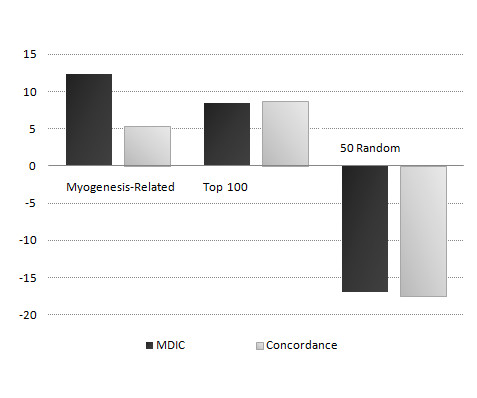
The improvement or deterioration of genes ranking in Sartorelli. Firstly, we selected 100 informative and 50 uninformative genes using Tomczak dataset and extracted their ranks in Sartorelli. Secondly, we trained 1PB classifier on Tomczak and tested on Sartorelli. Finally, we ranked genes according to the average error rate of 1PB classifier in predicting their values in Sartorelli. This figure illustrates the average improvement or deterioration of Myogenesis-Related, Top 100, and 50 randomly selected genes in Sartorelli generated with our method and the gene rankings generated by concordance model.